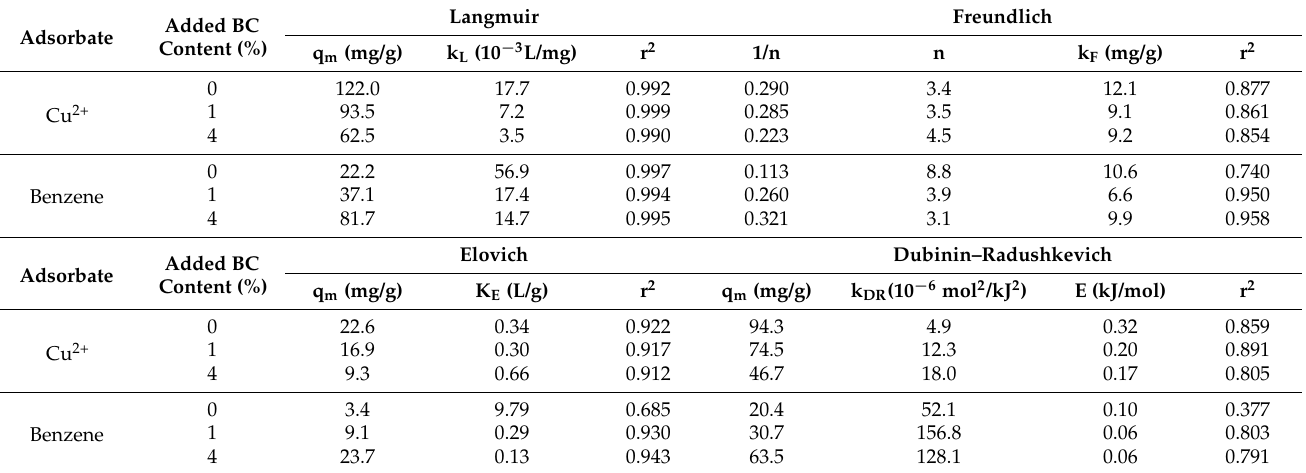
Table 2. Isotherm parameters of Cu 2+ and benzene adsorption onto alginate and alginate/biochar hydrogel beads (1 and 4%